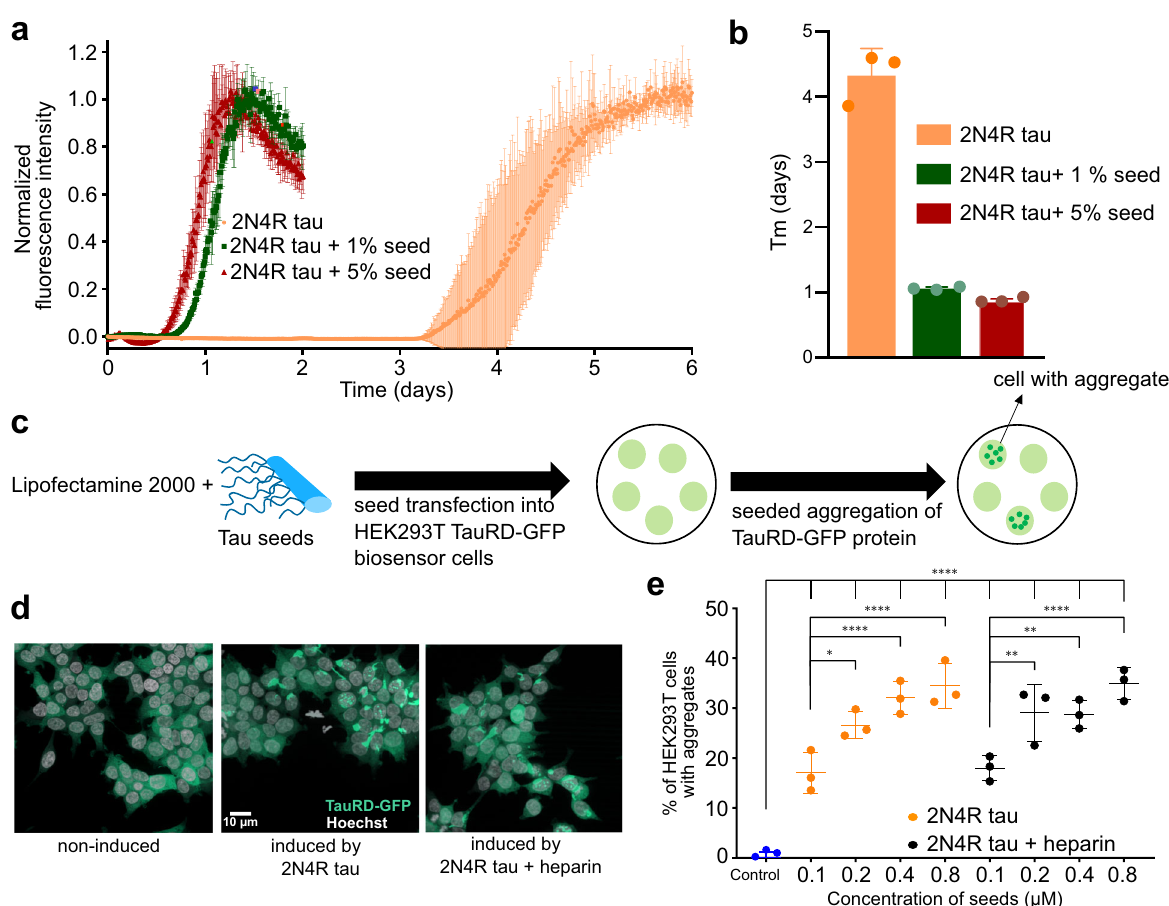
Fig. 5 Seeding activity of heparin-free tau fi brils. a Aggregation kinetics of 25 µ M 2N4R tau in the absence (orange) and presence of 1% (green) and 5% (red) tau seeds generated without heparin. Data are presented as mean ± standard deviation of n = 3 independent samples. b Half-time (Tm) of aggregation of 2N4R tau in the absence (orange) and presence of 1% (green), 5% (red) tau seeds (see ( a )). Data are presented as mean ± standard deviation of n = 3 independent samples. c Schematic representation of the process of seeding of tau aggregation in biosensor cells. d TauRD-GFP puncta in HEK293T biosensor cells 23 , expressing the tau repeat domain carrying the mutations P301L and V337M, induced by 2N4R tau seeds, which were formed either in the absence (left) or presence of heparin (right). The result was reproducible for three independently performed experiments. e Comparison of the ef fi ciency of 2N4R tau seeding in tau biosensor cells. Fibrils were generated by aggregating 2N4R tau in the absence (orange) or presence (black) of heparin. Different concentrations of seeds (0.1 – 0.8 µ M) were used to induce TauRD-GFP puncta. The statistical analysis between the % of HEK293T cells with puncta induced by each concentration of seeds in the absence/presence of heparin was performed by one-way ANOVA analysis. Fibrils of different concentrations were independently transfected n = 3 times. Error bars represent the standard deviation of three independent experiments. Four stars represent p < 0.0001, two stars represents p ≤ 0.0021, one star represents p